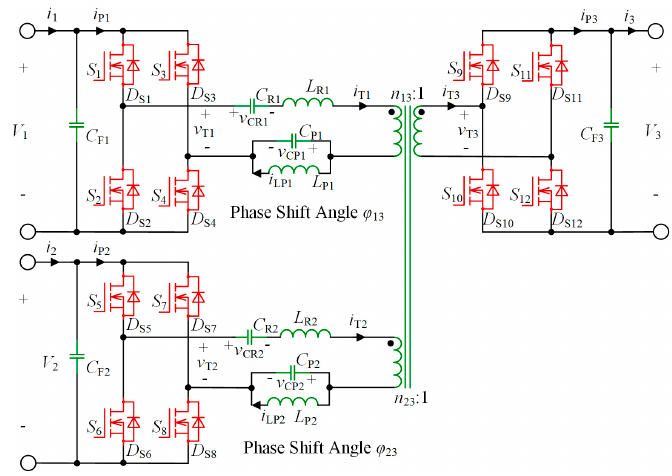
Figure 2. Topology of the proposed isolated MR-TP-BDC.